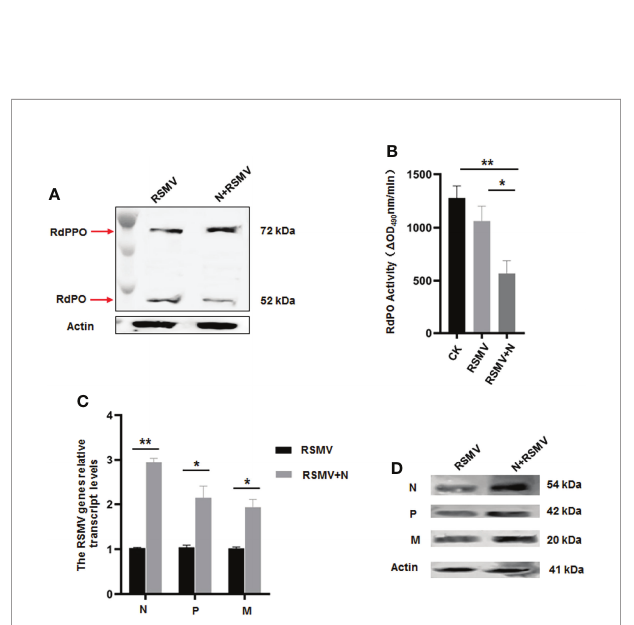
FIGURE 7 | Schematic model depicting RSMV N-induced melanization evading in insect vectors. Once RSMV particles successfully overcome the midgut barrier and release into hemolymph. The serine protease (SP) is progressively activated to catalyze PPO into active PO. However, RMSV N directly interacts with PPO and prevents the production of PO, fi nally impairing the biosynthesis of melanin and bene fi ting the survival of RSMV from melanization.